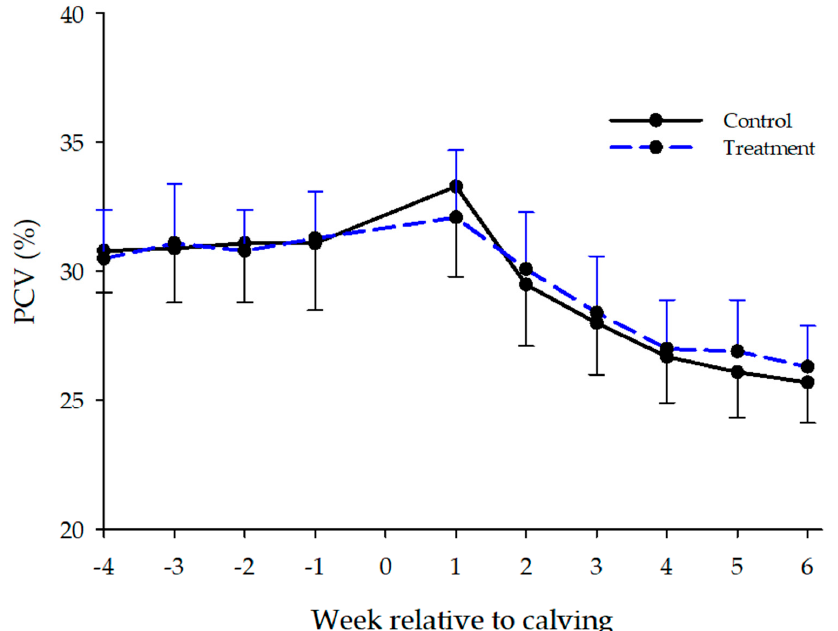
Figure 10. Packed cell volume of dairy cattle receiving either a P deficient diet (LP, n = 15) or a diet with adequate P content (AP, n = 15) in the dry